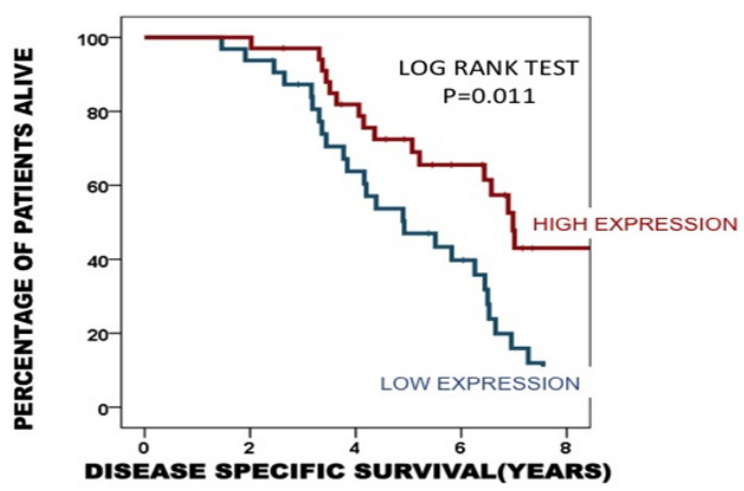
Figure 2. Kaplan Meier plot demonstrates that those patients whose tumours express high nuclear pAR 308 (34 patients) have a longer disease specific survival than those patients whose tumours exhibit low pAR 308 expression (32 patients).